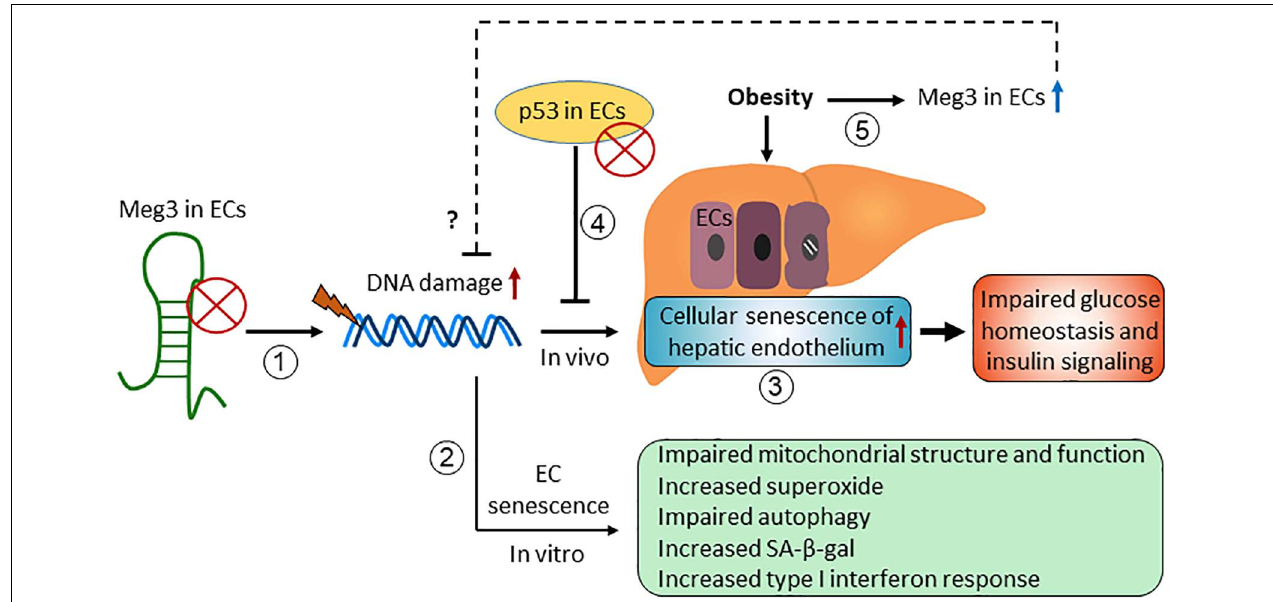
FIGURE 4 | The role of maternally expressed gene 3 (Meg3) in regulating endothelial cellular